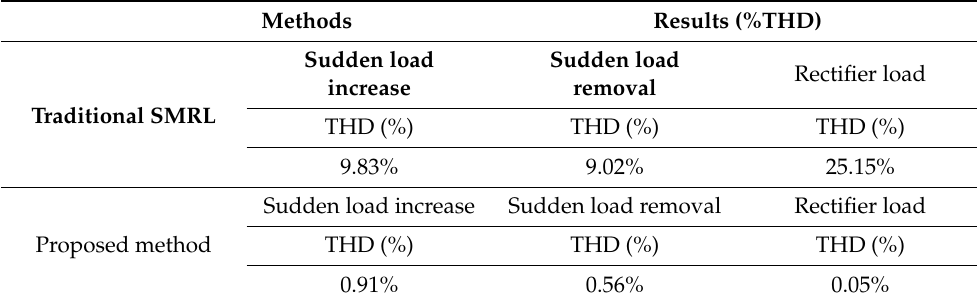
Figure 20. Upcoming research extended to the development of a three-phase T-type inverter.